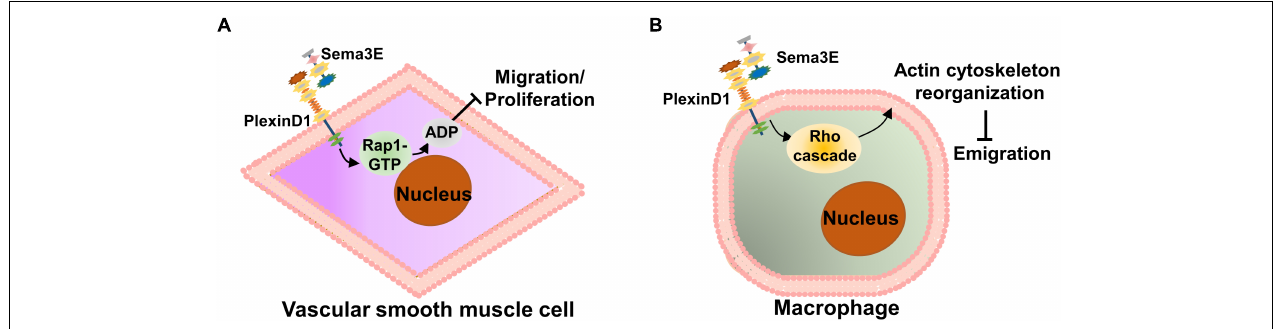
FIGURE 3 | Schematic representation of the role of Sema3E in atherosclerosis. (A) In the early stage of atherosclerosis, Sema3E and its receptor PlexinD1 are remarkably decreased in atherosclerotic plaques. Sema3E inhibits VSMC migration and proliferation by inactivating Rap1-AKT signaling pathways via binding to PlexinD1 in the process of neointimal formation. (B) Sema3E and its receptor PlexinD1 are remarkably increased in monocyte-macrophages of advanced atherosclerotic plaques. Sema3E inhibits the directional emigration of macrophages by disrupting the Rho GTPase signaling cascade and actin cytoskeleton